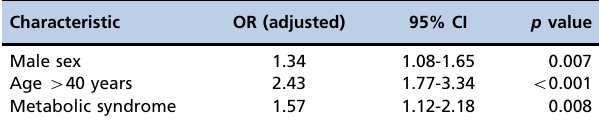
Advanced liver disease* is defined as Metavir score F3 or F4 and/or clinical manifestations or ultrasound/endoscopy findings consistent with cirrhosis. Table 4 - Factors independently associated with advanced liver disease according to multiple logistic regression analysis.